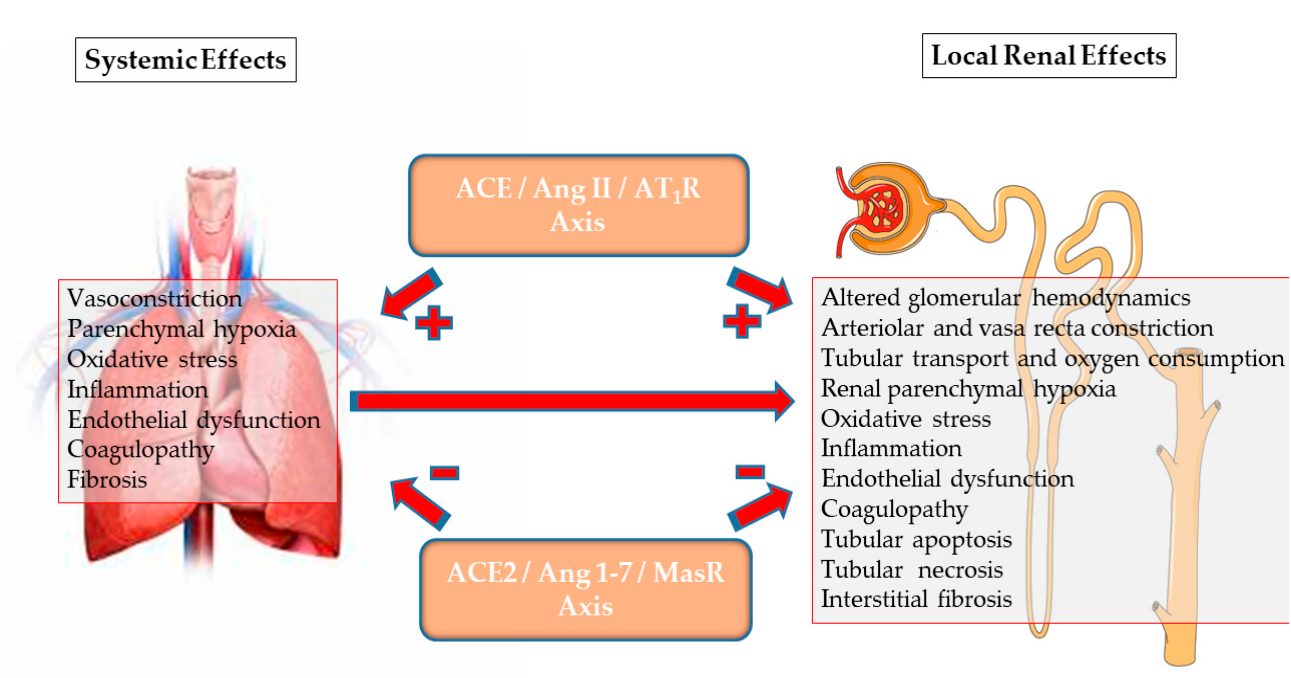
Figure 2. Systemic and direct renal effects of the two arms of RAS leading to acute kidney injury (AKI): the pressor and harmful arm, mediated by the ACE/Ang II/AT1R axis, and the counteracting depressor and protective arm, mediated by the ACE2/Ang-(1-7)/MasR axis and Ang II/AT2R. In addition to a direct impact on the kidney, systemic RAS imbalance, as occurs in COVID-19 disease, can participate in acute renal dysfunction and injury, which may progress to CKD.